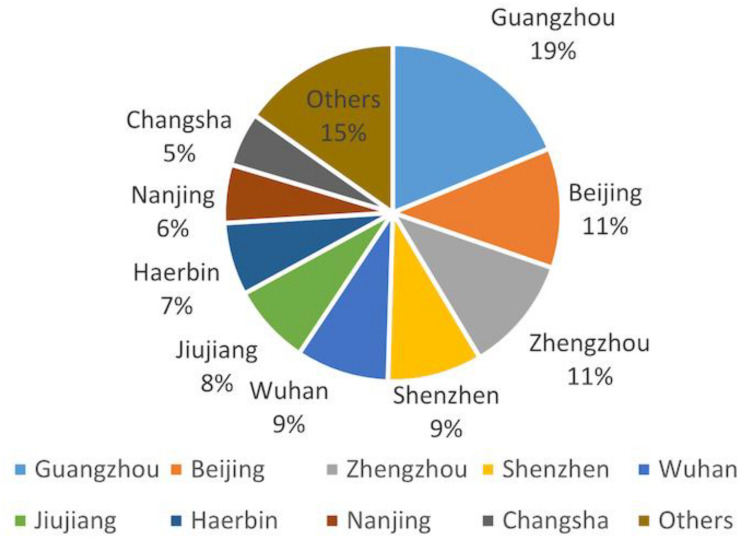
Geographical distribution of the respondents.